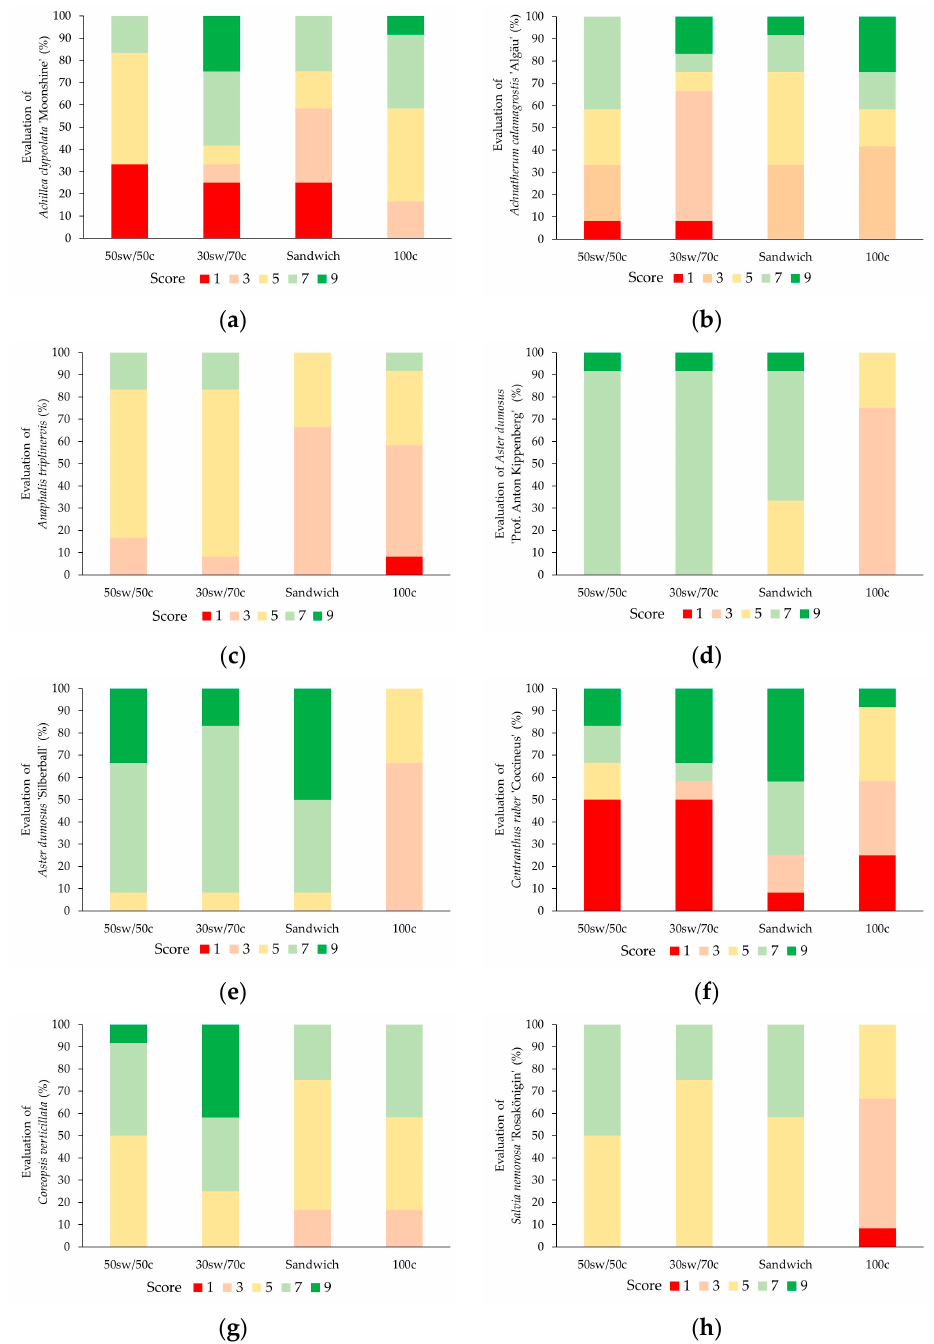
Figure 4. Influence of vegetation mats on overall impressions of individual perennials at the 7th assessment date (end of September 2015): 1 = plant failure, 3 = sufficient, 5 = satisfactory, 7 = good, 9 = very good for ( a ) Achillea clypeolata ‘Moonshine’, ( b ) Achnatherum calamagrostis ‘Algäu’, ( c ) Anaphalis triplinervis , ( d ) Aster dumosus ‘Prof. Anton Kippenberg’, ( e ) Aster dumosus ‘Silberball’, ( f ) Centranthus ruber ‘Coccineus’, ( g ) Coreopsis verticillata , and ( h ) Salvia nemorosa ‘Rosakönigin’.